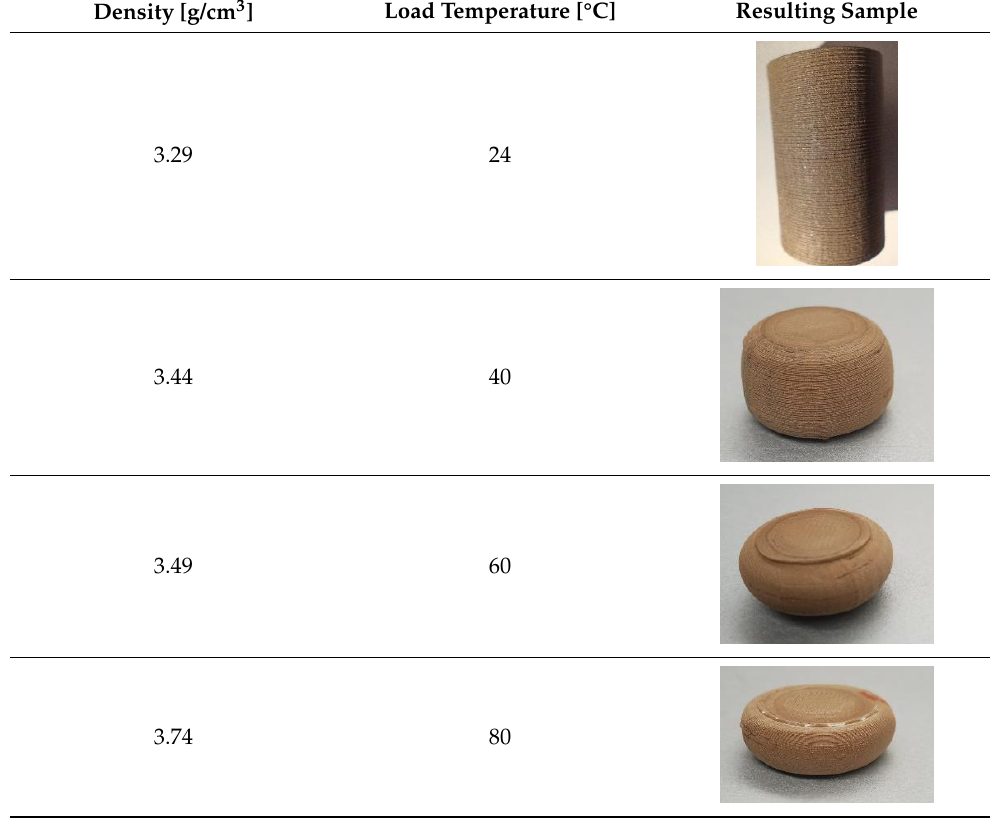
Table 3. Compressive modulus comparison between FDM 3D printed bronze-filled PLA and 60 minutes sintered bronze powder.